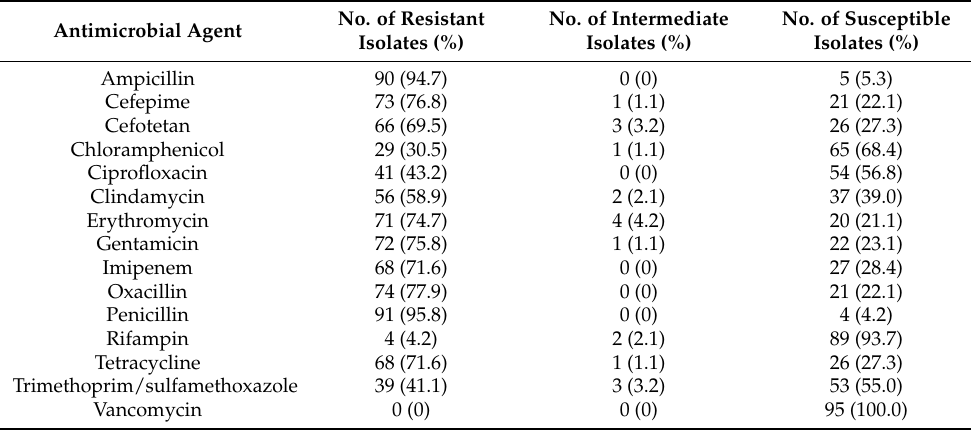
Table 2. Antimicrobial-agent resistance profiles of the 95 S. aureus strains. Antimicrobial